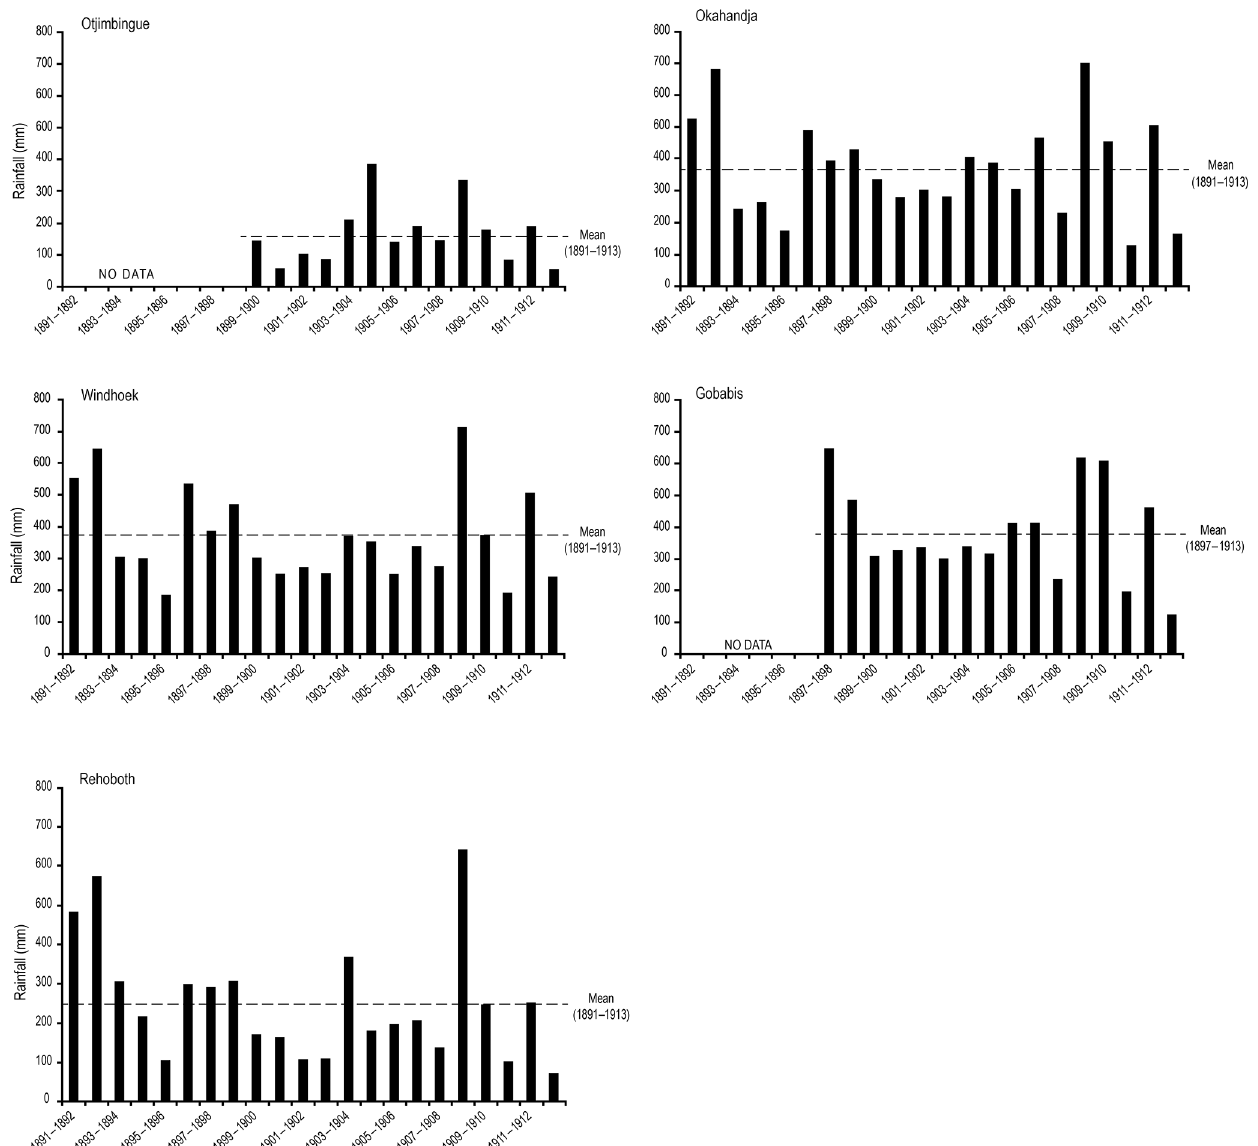
Figure 3. Wet-season (November–April) rainfall totals for various stations across central Namibia between 1891 and